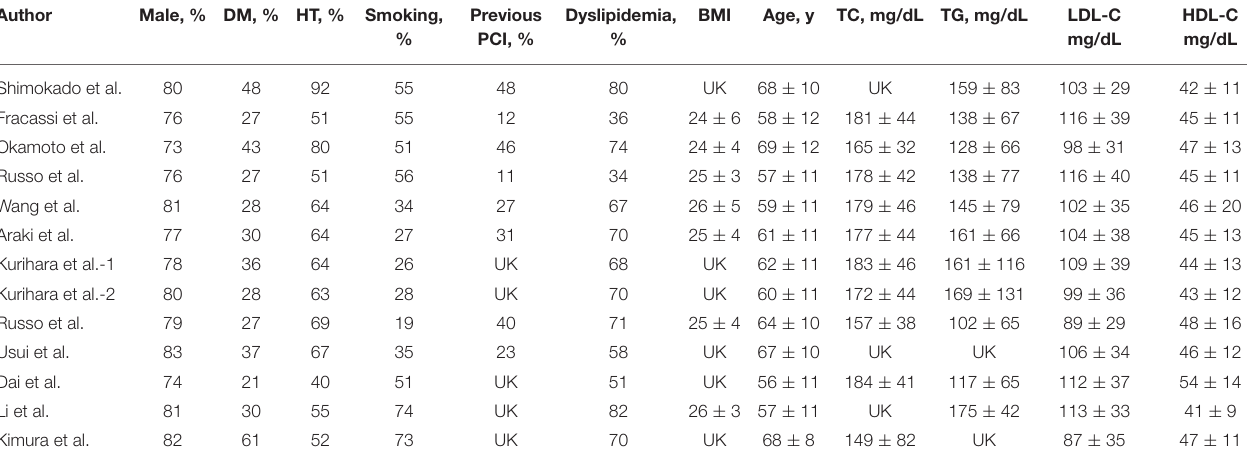
TABLE 2 | Baseline characteristics of included